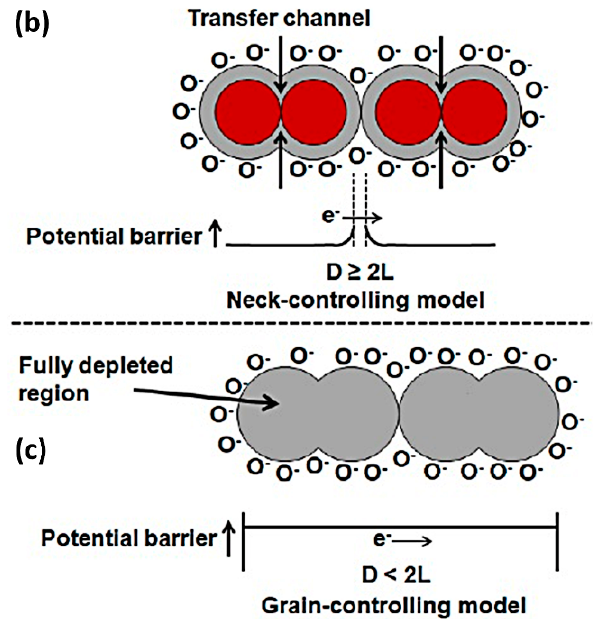
Figure 3. Schematic model of crystallite size effect on the sensitivity of MOS gas sensors: ( a ) D ≫ 2L, ( b ) D ≥ 2L, and ( c ) D < 2L. Reprinted with permission from Ref. [31]. Copyright 2022, Elsevier.